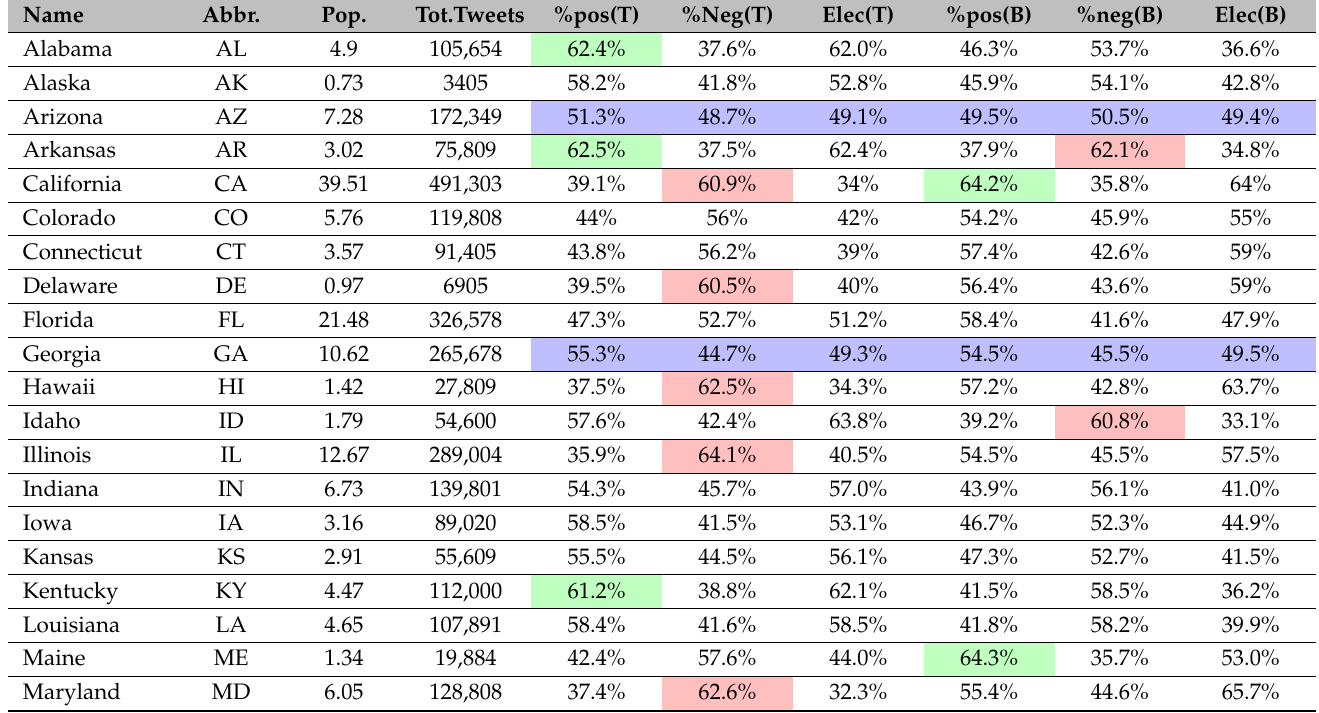
Table 1. U.S. Election results 2020 and comparison with Twitter